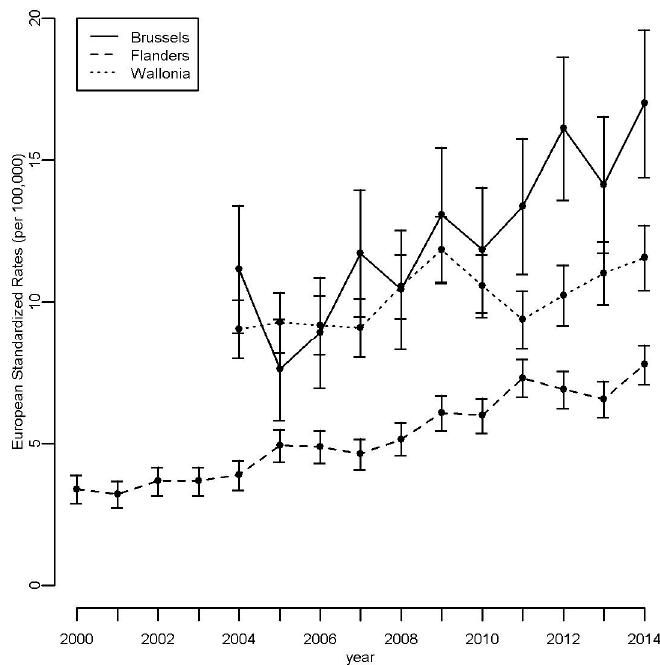
Figure 2. Age- and sex-standardized rates (standardized according to the European Standard Population) of thyroid cancer by year of diagnosis and region in Belgium, 2000/2004–2014.